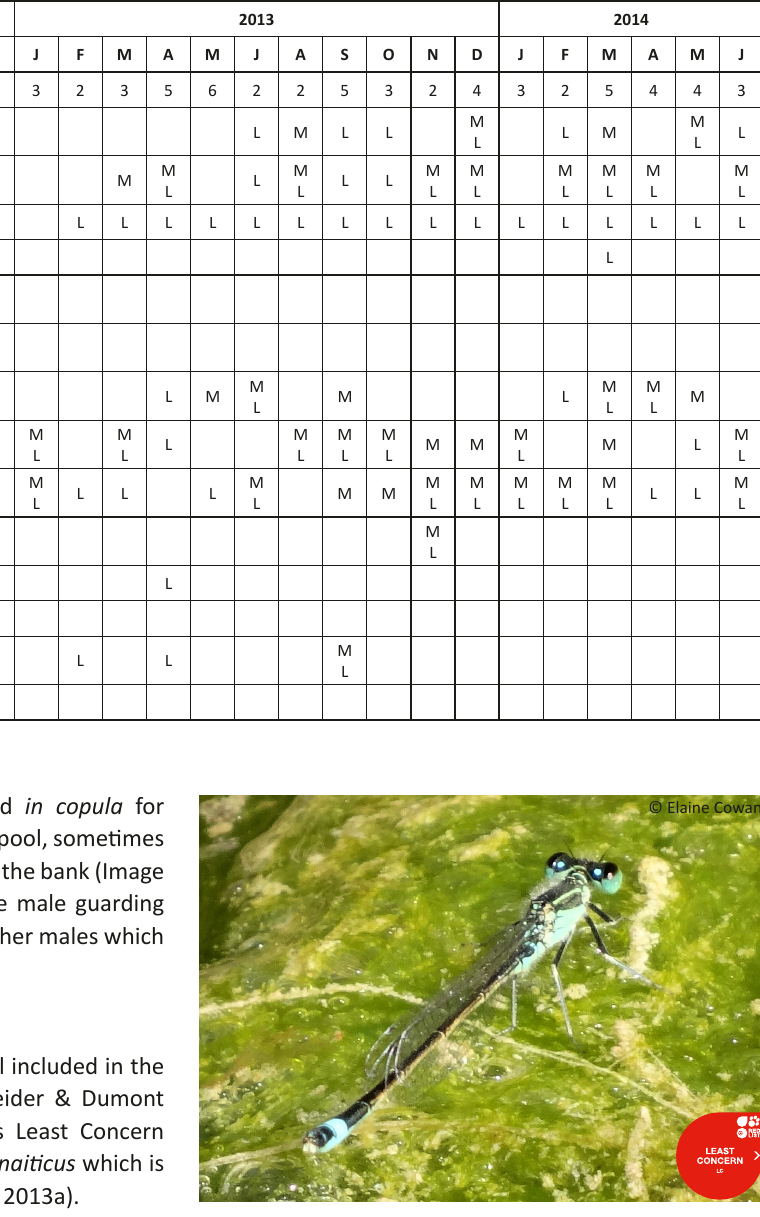
Image 2. Male Ischnura evansi , 4 January 2014. Greenish-blue face, postocular spots and thorax with visible antehumeral stripes. Abdomen dark above and paler below. The black pattern on the top of the second abdominal segment does not extend as a black saddle on the sides, which are greenish. The posterior ‘tail-light’ on abdominal segment 8 extends all around the